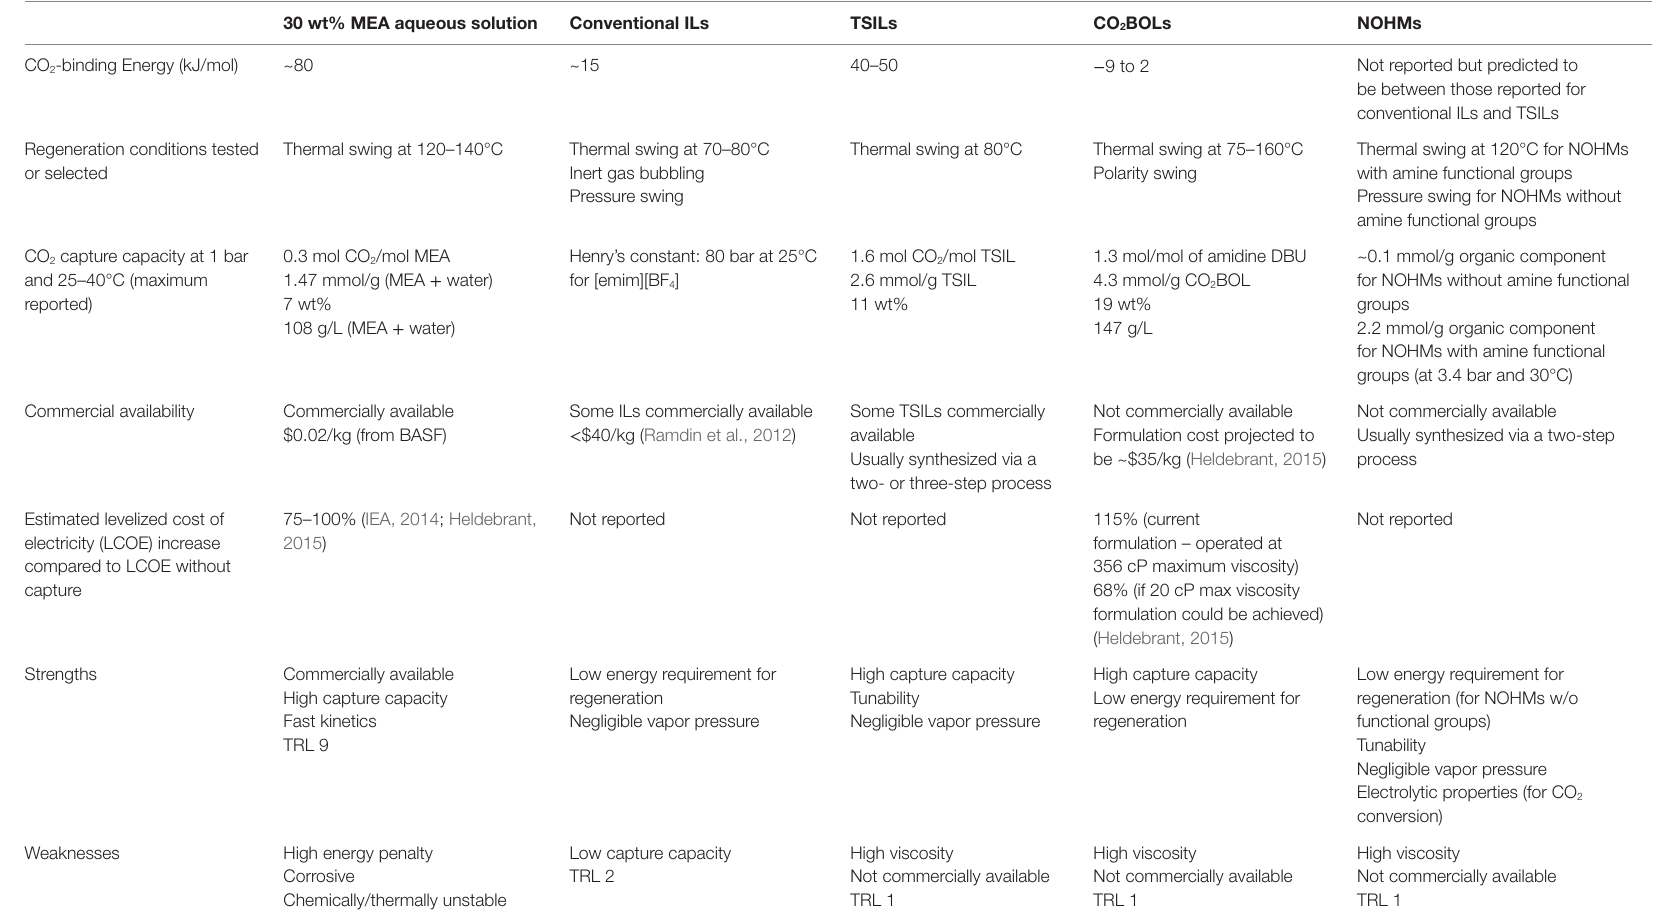
TABLe 1 | Overview of the properties, merits, and weaknesses of the reviewed anhydrous solvents with respect to CO 2 capture and compared to MeA aqueous solvent.